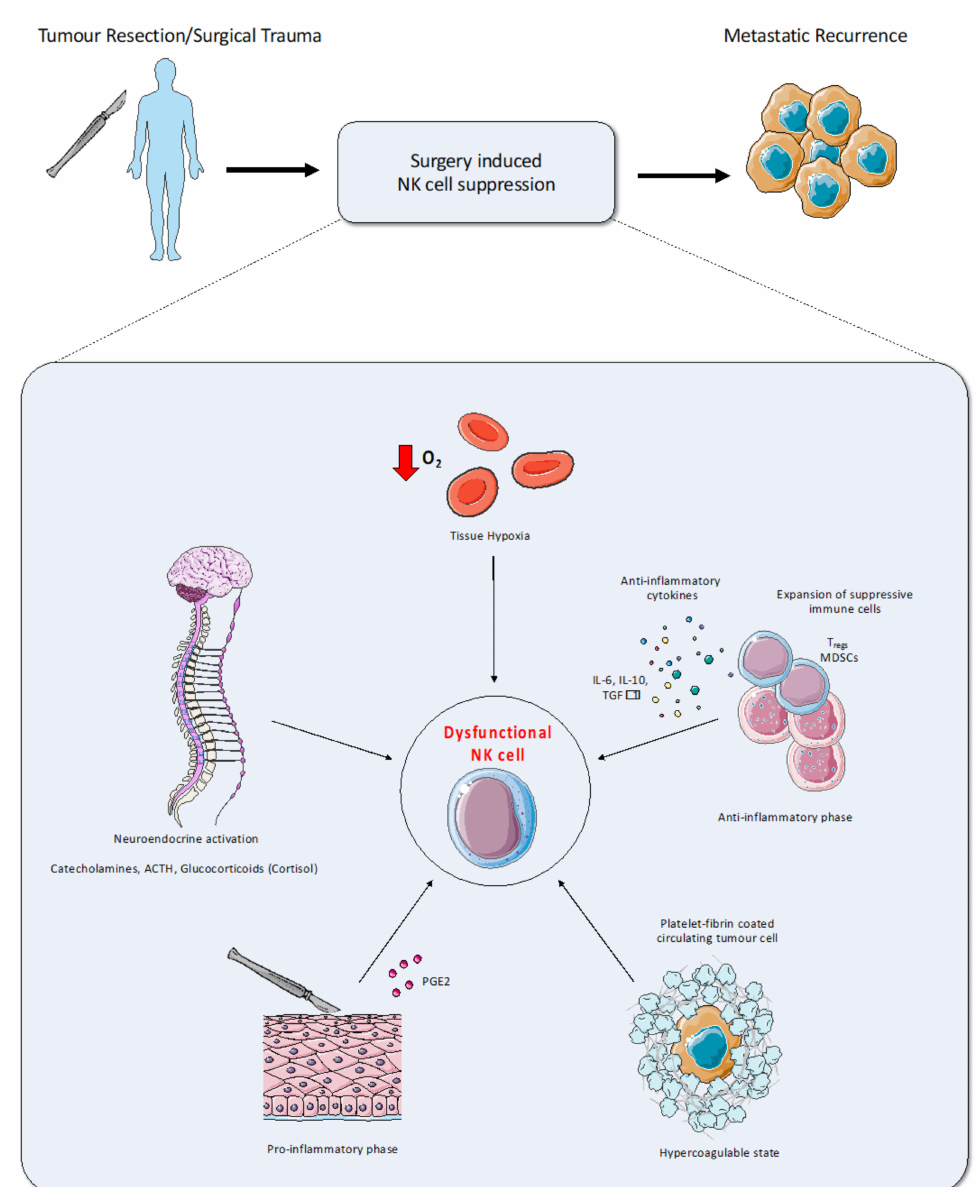
Figure 1. Potential mechanisms of postoperative cancer recurrence. Numerous changes occurring in the postoperative period have been hypothesized to be responsible for NK cell suppression and postoperative metastasis. These include tissue hypoxia, neuroendocrine activation, a pro-inflammatory phase, a hypercoagulable state, and an anti-inflammatory phase characterized by the release of anti-inflammatory cytokines and the expansion of immunosuppression populations in addition to cellular immune